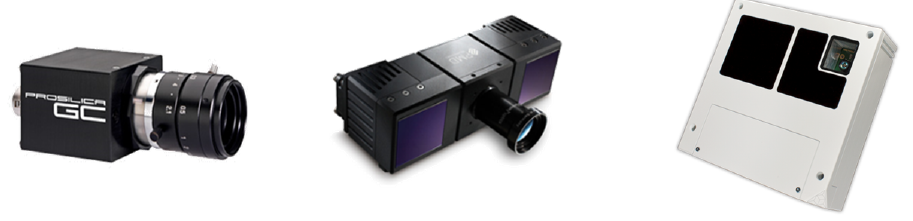
Figure 15: Cameras used at EPOS: Prosilica GC-655M (left), PMDtec Camcube 3.0 (center) and Bluetech- nix Argos3D-IRS1020 DLR Prototype